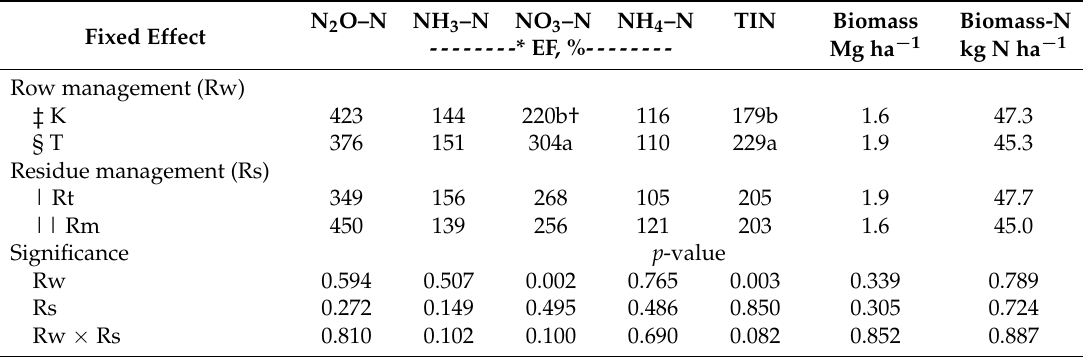
Table 4. Treatment means and significance of soil and gaseous N pools over the entire sampling period. Clover biomass and biomass-N are from the 28 June sampling.